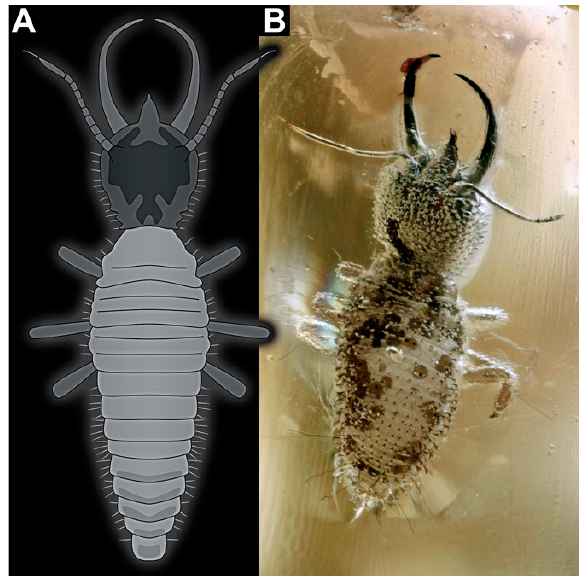
Figure 30. Specimens in Baltic amber; not to scale. ( A ) Specimen 97, modified after Ross [104]. ( B ) Specimen 98, provided by Marius Veta (www.ambertreasure4u.com, accessed on 23 December 2022). (46) Specimen 98 is preserved in Baltic amber. The specimen was not directly